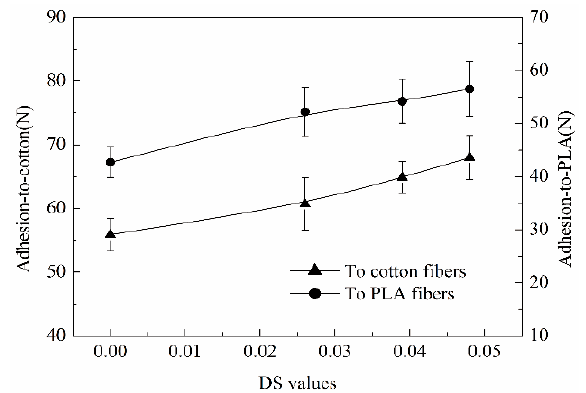
Figure 5. Influence of quaternization/hydroxypropylsulfonation on adhesion of OTS to cotton and polylactic acid (PLA) fibers,